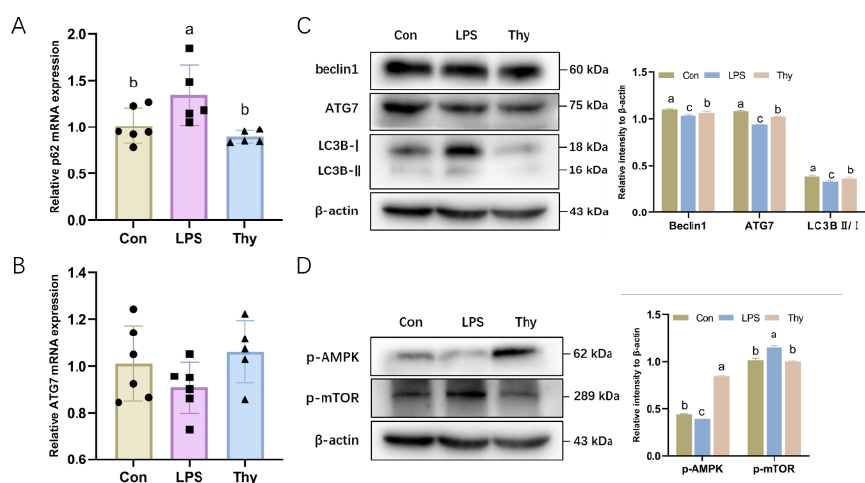
Figure 5. Thymol regulates the AMPK–mTOR autophagy pathway during inflammatory re- sponses. The mRNA levels of autophagy-related genes ( A ) p62 and ( B ) ATG7 in the liver ( n = 5–6); ( C ) The expression and quantification of autophagy-related proteins in the liver as determined by Western blotting. Values are normalized to β -actin levels and expressed as the mean ± SD ( n = 6); ( D ) The expression and quantification of p-AMPK and p-mTOR in the liver as determined by Western blotting. Values are normalized to β -actin levels and expressed as the mean ± SD ( n = 6). Con, control; Thy, thymol. Differences were presented with different superscript letters ( p < 0.05).